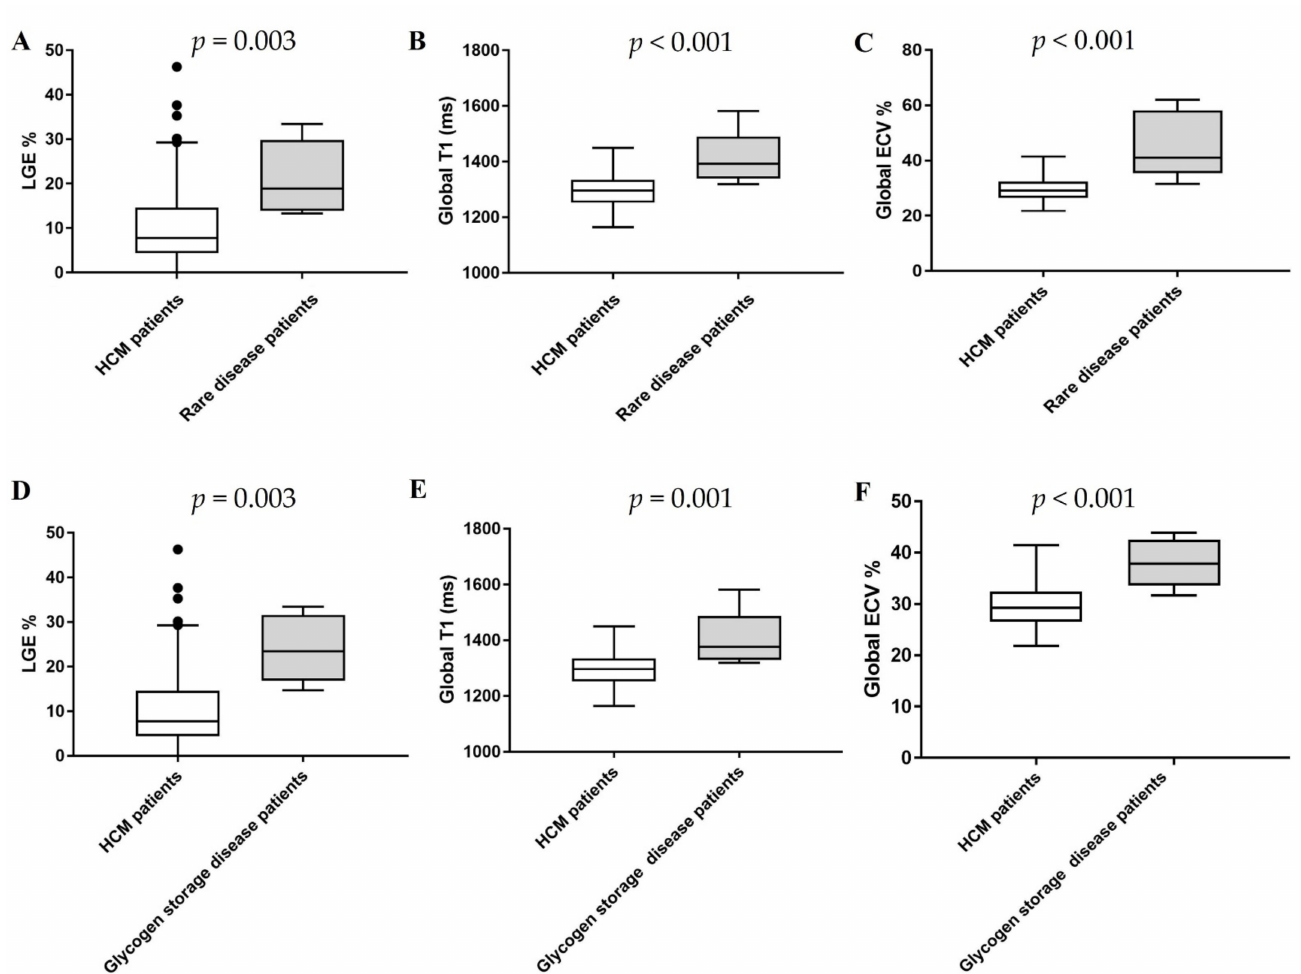
Figure 4. LGE, global native T1, and ECV comparisons between HCM patients and rare disease patients. The comparisons of LGE%, global T1 and ECV between the patients with rare diseases including patients with amyloidosis and HCM patients ( A – C ), The comparisons of LGE%, global T1 and ECV between the patients with rare diseases excluding patients with amyloidosis and HCM patients ( D – F